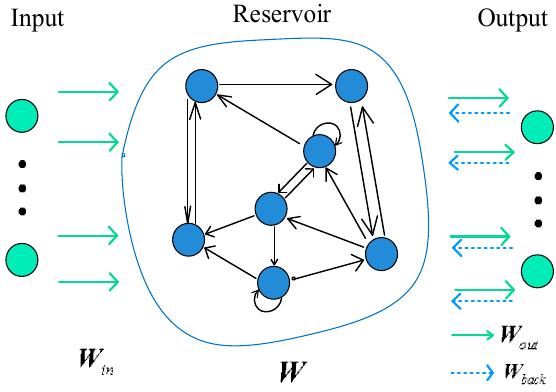
Figure 1. The basic structure of echo state network.